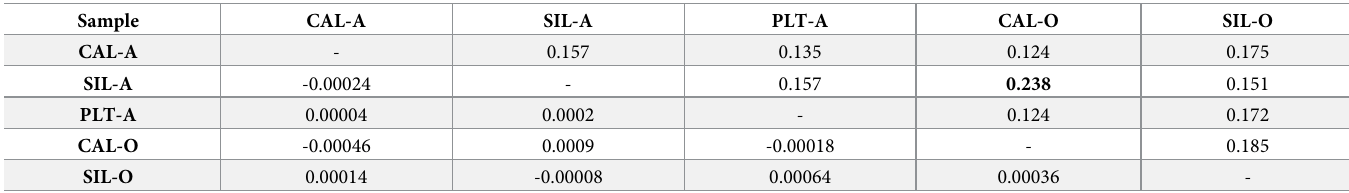
Table 3. Genetic differentiation estimates among Pinus sylvestris adult and offspring samples from calcareous and siliceous soils at Sierra de Ayllo´n. Sample CAL-A SIL-A PLT-A CAL-A - SIL-A PLT-A 0.0002 0.172 CAL-O -0.00046 SIL-O - CAL-A, SIL-A and PLT-A, adult samples from calcareous and siliceous natural populations and from nearby plantations, respectively; CAL-O and SIL-O, offspring samples from calcareous and siliceous natural populations; above diagonal: D est , Jost’s differentiation index; below diagonal: F ST , AMOVA-based population differentiation index. Estimates in bold are significantly different from zero (after Bonferroni correction with global α =